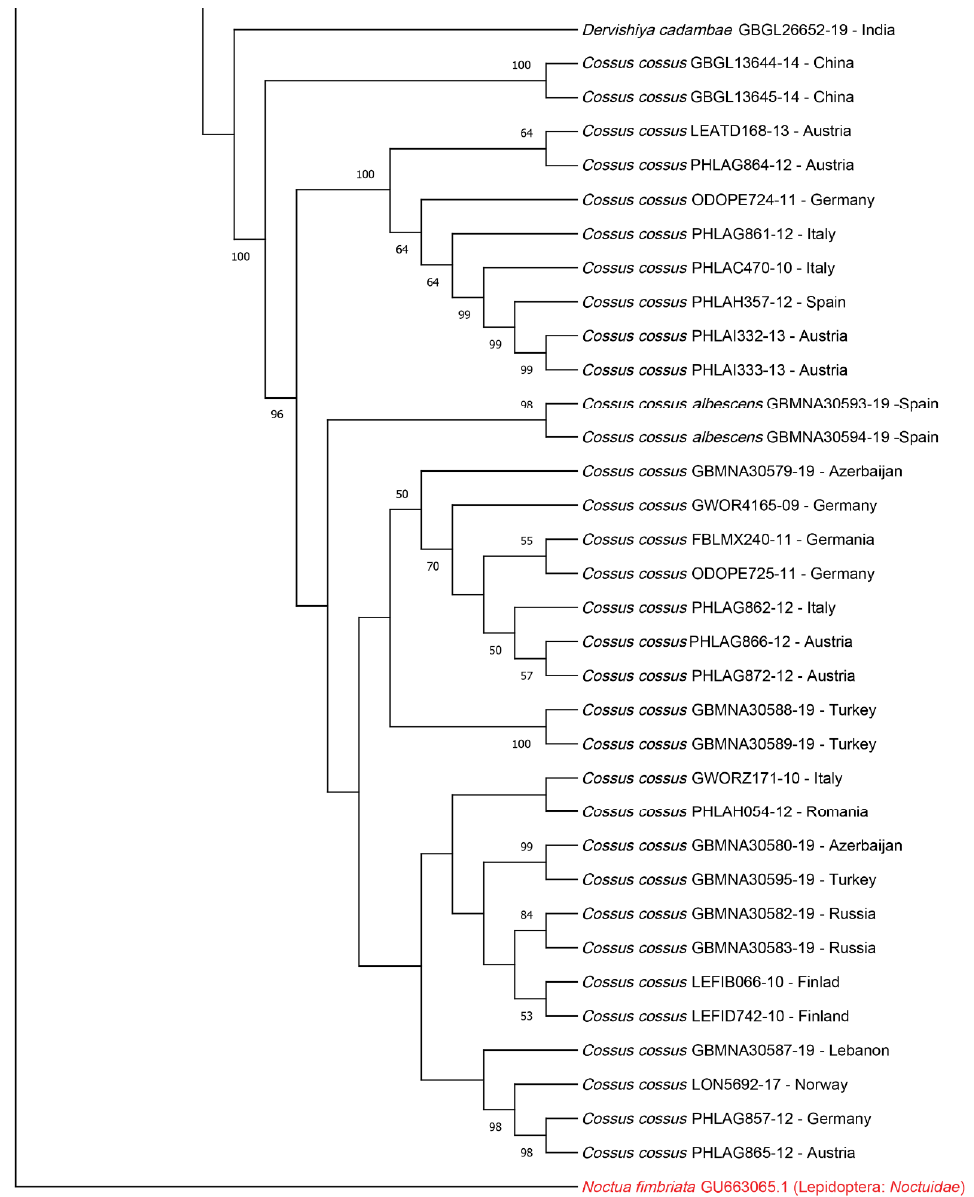
Figure 8. Neighbor-joining (NJ) tree of COI barcodes of Palearctic Cossidae. The tree includes sequences of P. thrips and as out-group Noctua fimbriata (Lepidoptera: Noctuidae ), all highlighted in